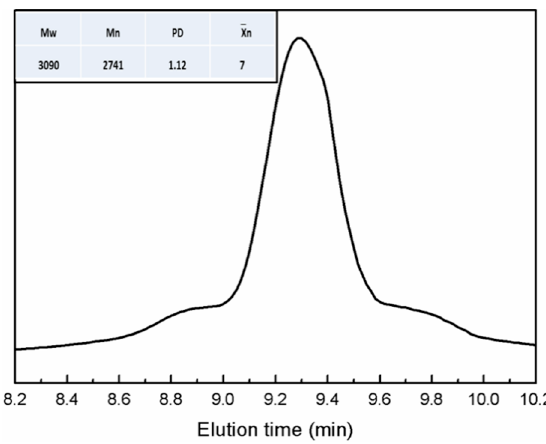
Figure 2. 1 H NMR ( a ), 31 P NMR ( b ) and 13 C NMR ( c ) spectra of SPDPC; 1 H NMR ( d ), 31 P NMR ( e ) and 13 C NMR ( f ) spectra of SAPC.